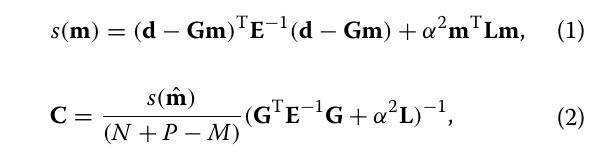
Fig. S2), resulting in a difference in secular velocities of < 1.4 mm/year and < 2.8 mm/year in horizontal and ver-